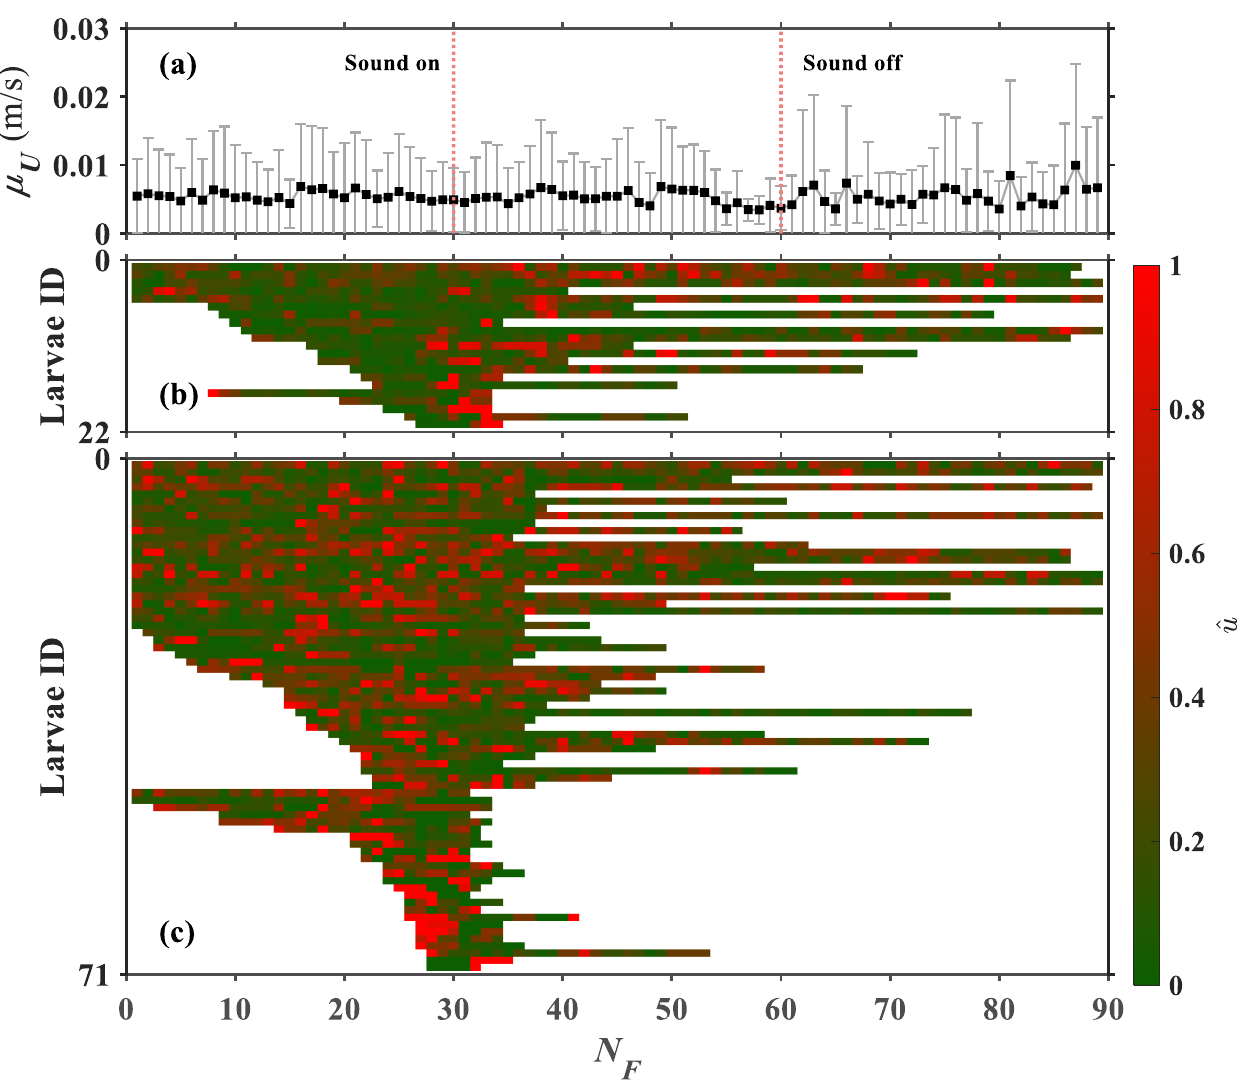
Figure 3. Time series of ( a ) bulk velocity with vertical error bars representing velocity variance, ( b ) normalized velocities of individual larvae that responded to sound stimuli ( c ) normalized velocities of individual larvae that did not respond to sound stimuli. Data shown for the 400 Hz tone, which showed the lowest variation of bulk velocities after the tone frame in Figure 2.